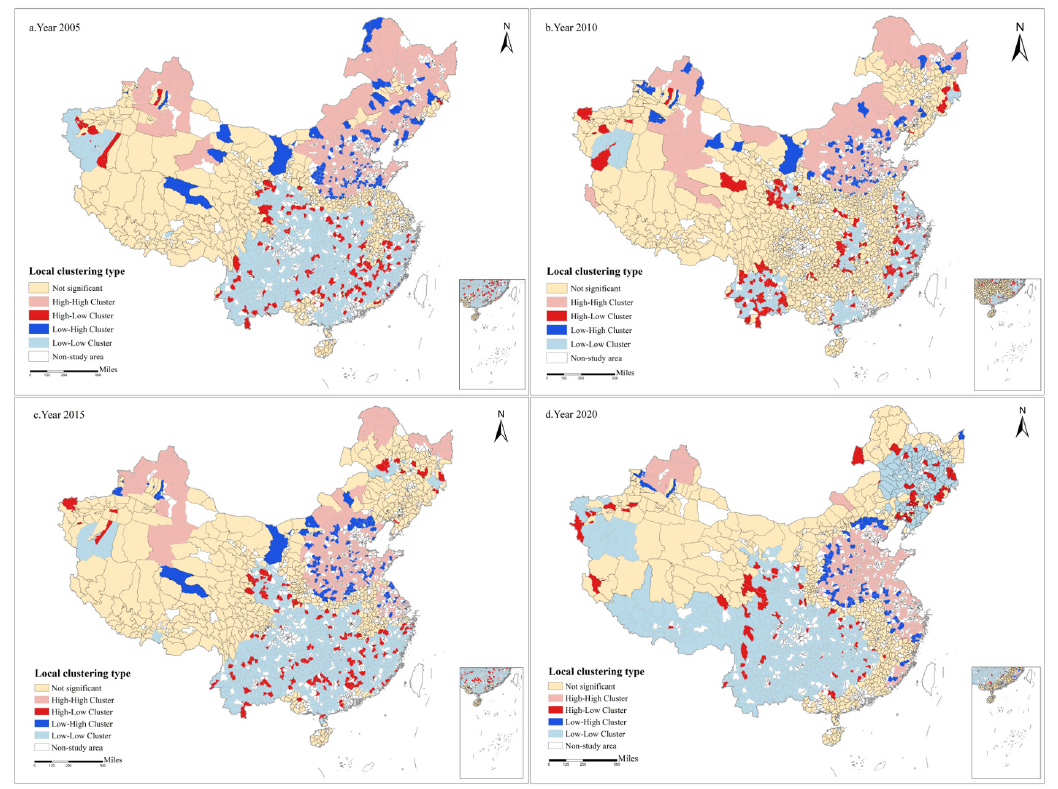
Figure 4. Local spatial clustering pattern of county sprawl.